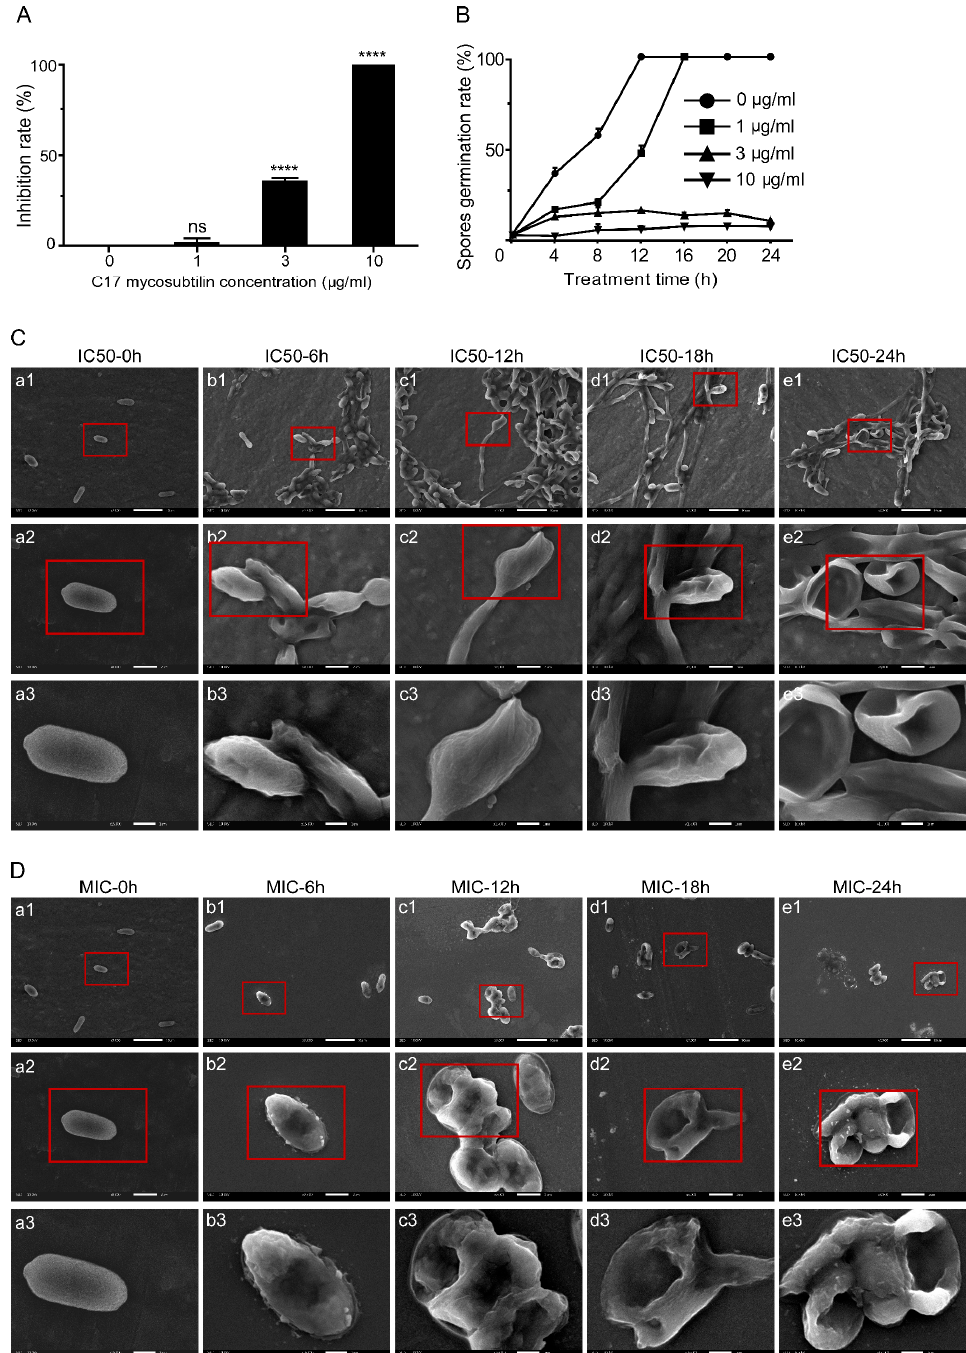
Figure 1. C17 mycosubtilin inhibits the growth and conidia germination of Vd 991 and affects its microscopic morphology. ( A ). The inhibition rate of different concentrations of C17 mycosubtilin on the growth of Vd 991. Data represent the average of three repetitions ± standard error (SD); statistical analyses were performed using one-way ANOVA. **** indicates extreme significance at p < 0.0001. ns: not significant. ( B ). Effects on spore germination of Vd 991 with C17 mycosubtilin. At least 200 spores were counted in each group, with 3 replicates. Data are shown as the mean ± SD. ( C , D ). SEM images of Vd 991 spores. Vd 991 was treated with C17 mycosubtilin at IC50 ( C ) and MIC ( D ) concentrations at different times. a, untreated Vd 991 spores (control); b1–e1, Vd 991 spores treated for 6 h, 12 h, 18 h, and 24 h, respectively. The red-framed area is the area displayed in the next row (b2–e2, and b3–e3, respectively).